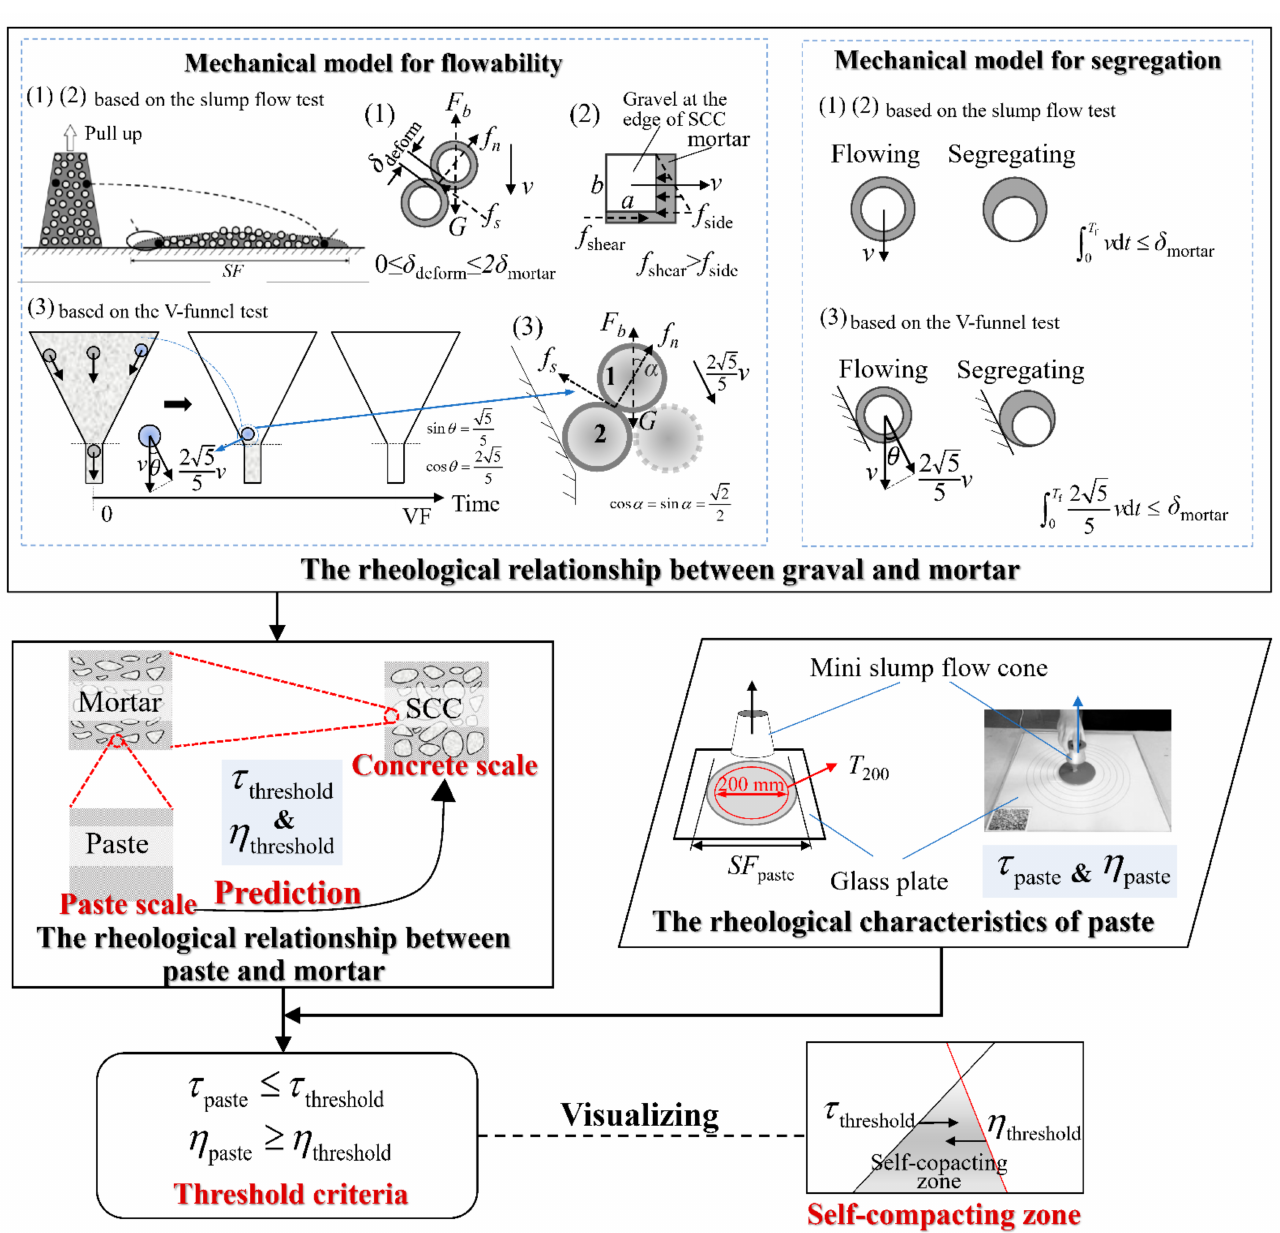
Figure 2. Schematic diagram of the multiscale rheological threshold